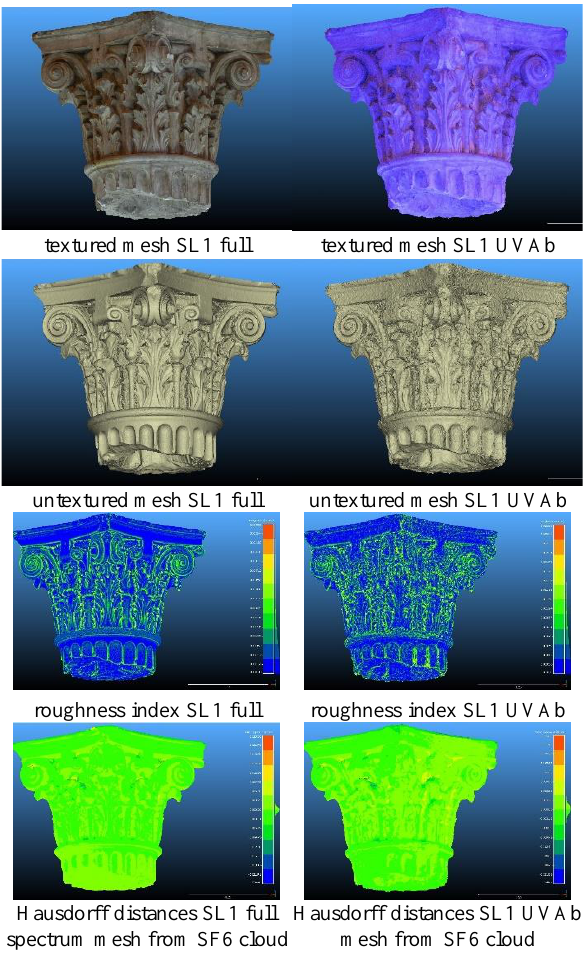
Figure 9: Agisoft Metashape OBJ2 results for full spectrum imagery (left) and UVAb imagery